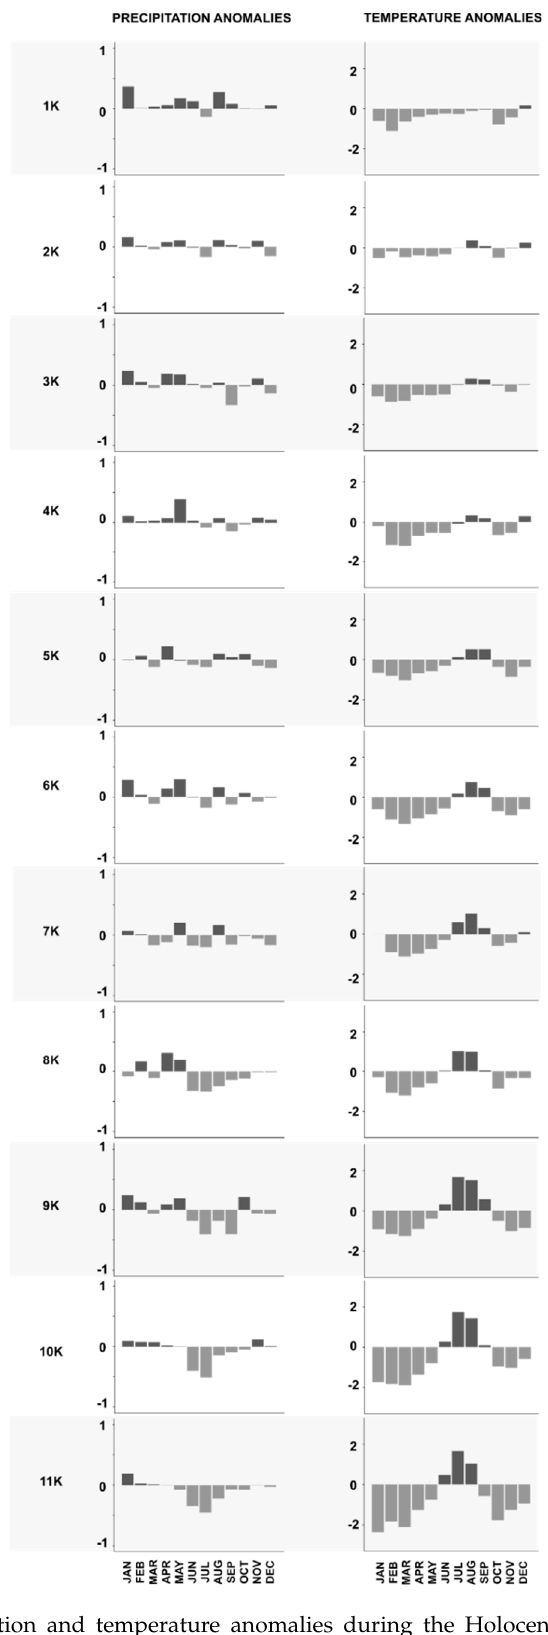
Figure A3. Precipitation and temperature anomalies during the Holocene calculated from the HadCM3B-M1 dataset [52].